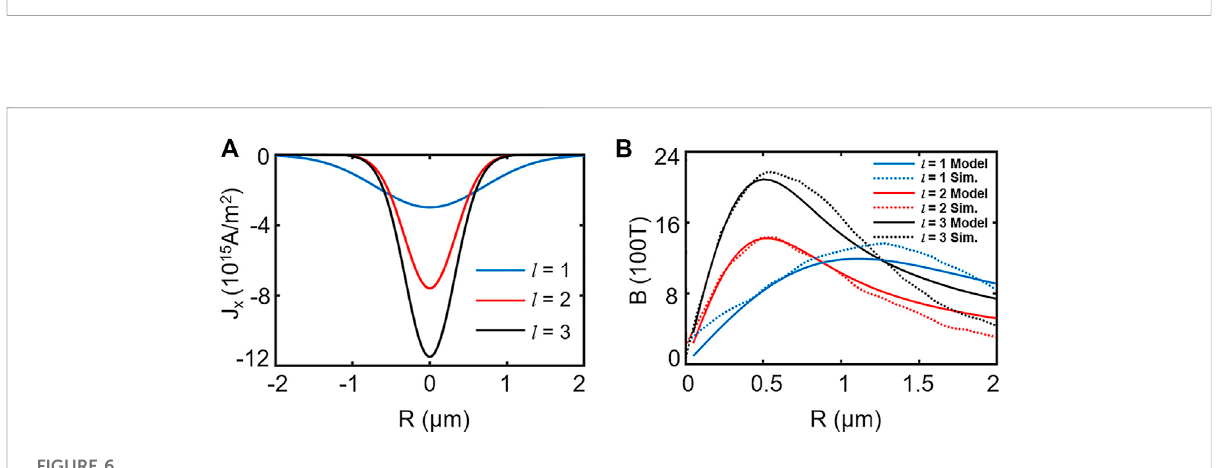
FIGURE 5 CollimationresultsdrivenbydifferenttopologicalstructuredLGlasers.Longitudinalcrosssectionsofelectronparticledensityne (A – C) ,current density (D – F) , and magnetic fi eld (G – I) at t = 200TL for topological charge of laser l = 1 (top row), l = 2 (center row), and l = 3 (bottom row). For the current, the forward-moving electrons in the plasma beam de fi ned here as a negative current are indicated in blue, whereas the positive current densities corresponding to the return current of the surrounding electrons are indicated in